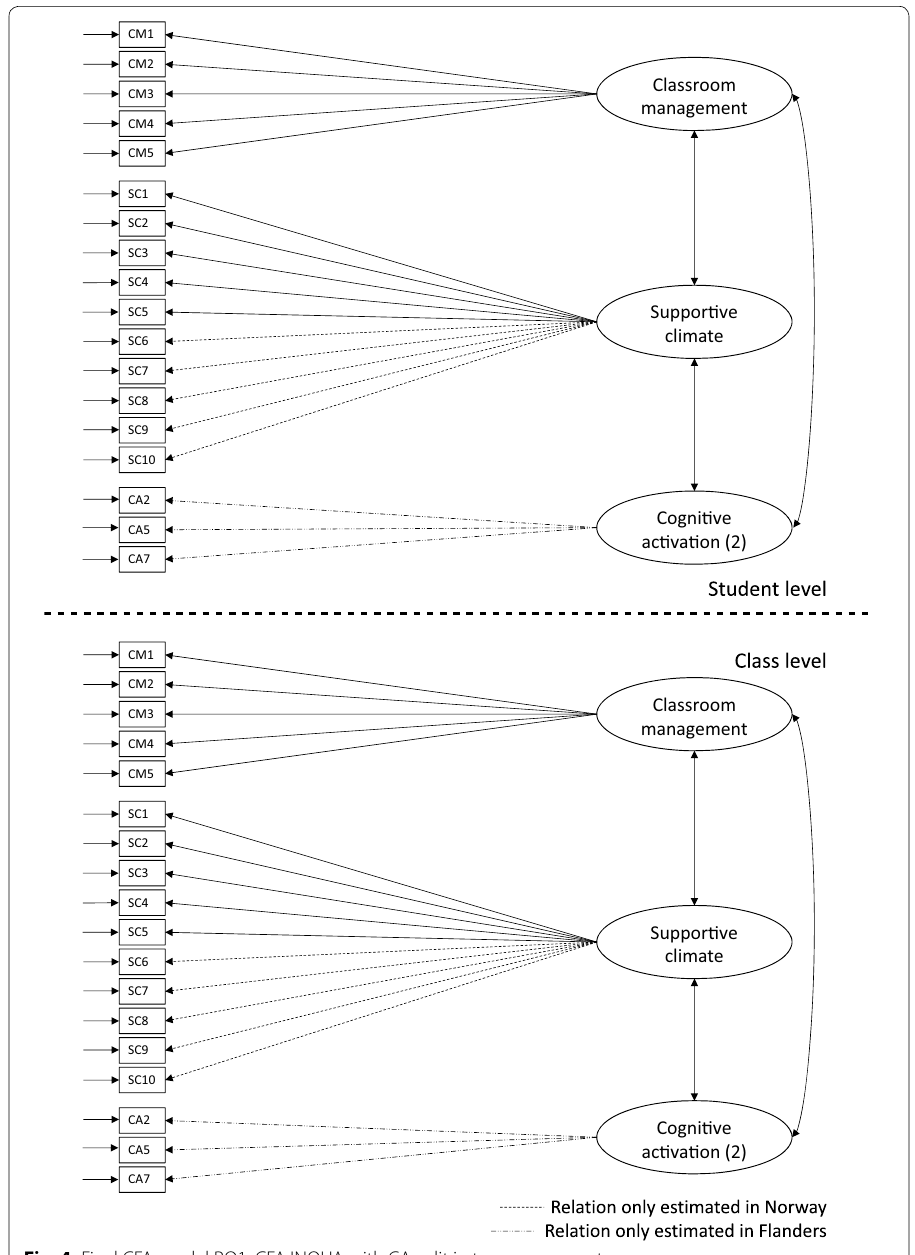
Fig. 4 Final CFA model RQ1: CFA INQUA with CA split in two